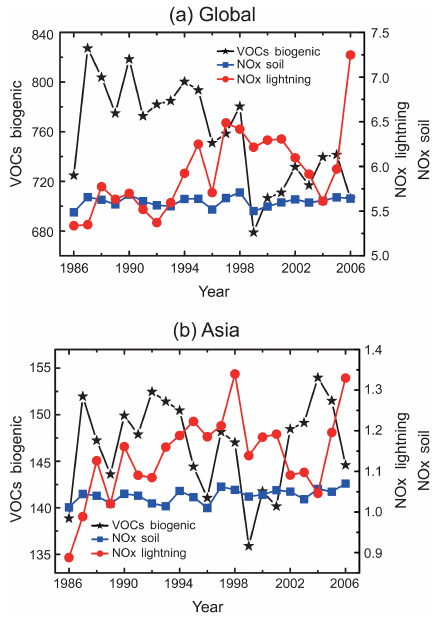
Figure 2. The evolution of annual natural emissions summed globally and for Asia (60–150 ◦ E, 10 ◦ S–55 ◦ N) for lightning NO x (TgNyr − 1 ) , soil NO x (TgNyr − 1 ) , and biogenic VOCs (TgCyr − 1 ) from